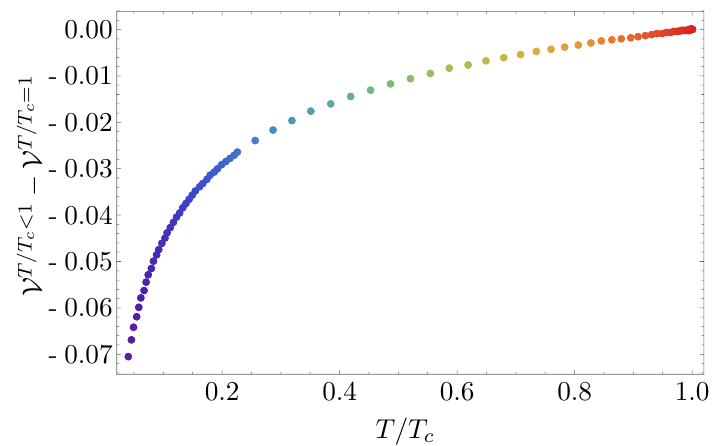
Figure 3 . Relative complexity as de(cid:12)ned in (3.3) shown as a function of T=T c . Although, as discussed in the text, in the Kondo model this quantity is by de(cid:12)nition (cid:12)nite as (cid:15) ! 0, we have calculated these points using an explicit cuto(cid:11) (cid:15) = 10 (cid:0) 10 in order to avoid numerical